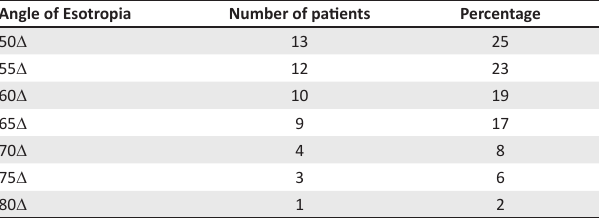
TABLE 1: Distribution of pre-operative angle of deviation as number and percentage of the total of 52 patients. Angle of Esotropia